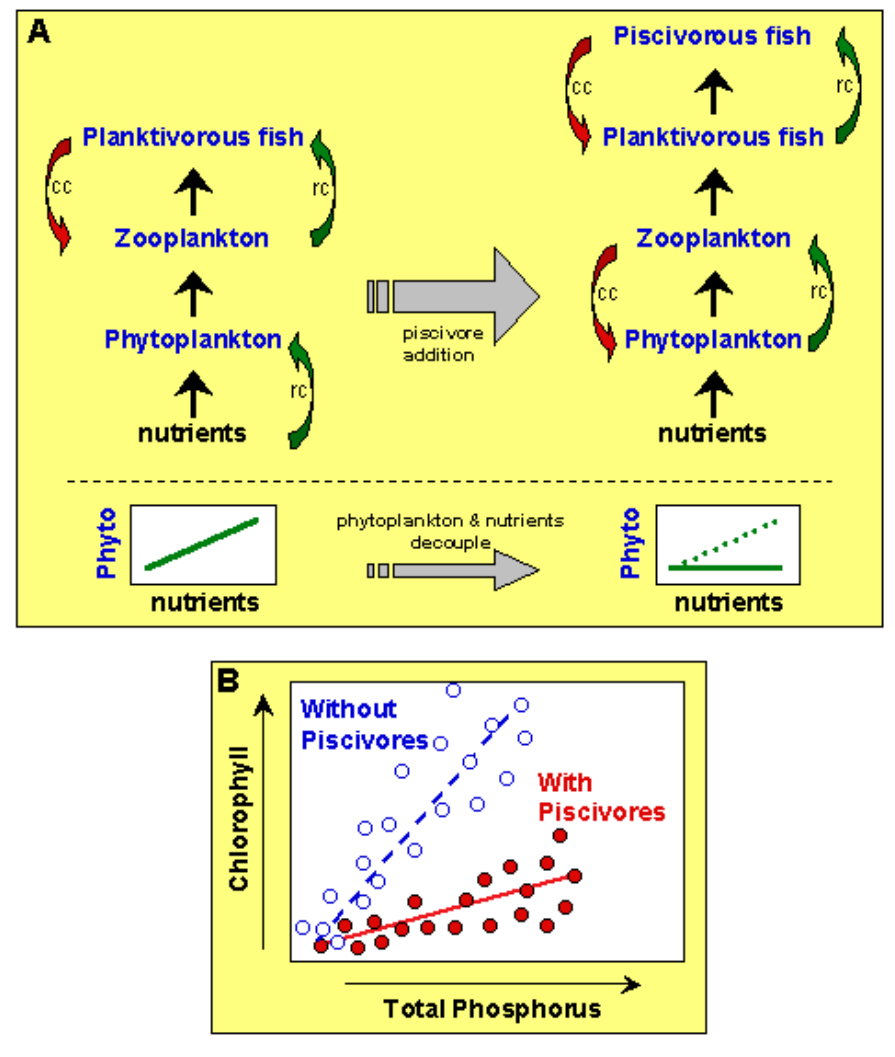
FIGURE 3. (A) Trophic cascade hypothesis viewed according to HSS[11]. The food chain on the left functions predominantly as a 3- level system. The food chain on the right results from the addition of piscivores and functions predominantly as 4-level system. Red arrows denote consumer control (cc) and green arrows denote resource control (rc). Note that the shift from a 3-level food chain to 4- level food chain results in a decoupling of phytoplankton from nutrients (e.g., phosphorus). (B) Hypothetical effect of piscivores on chlorophyll–total phosphorus relationship in lakes with planktivorous